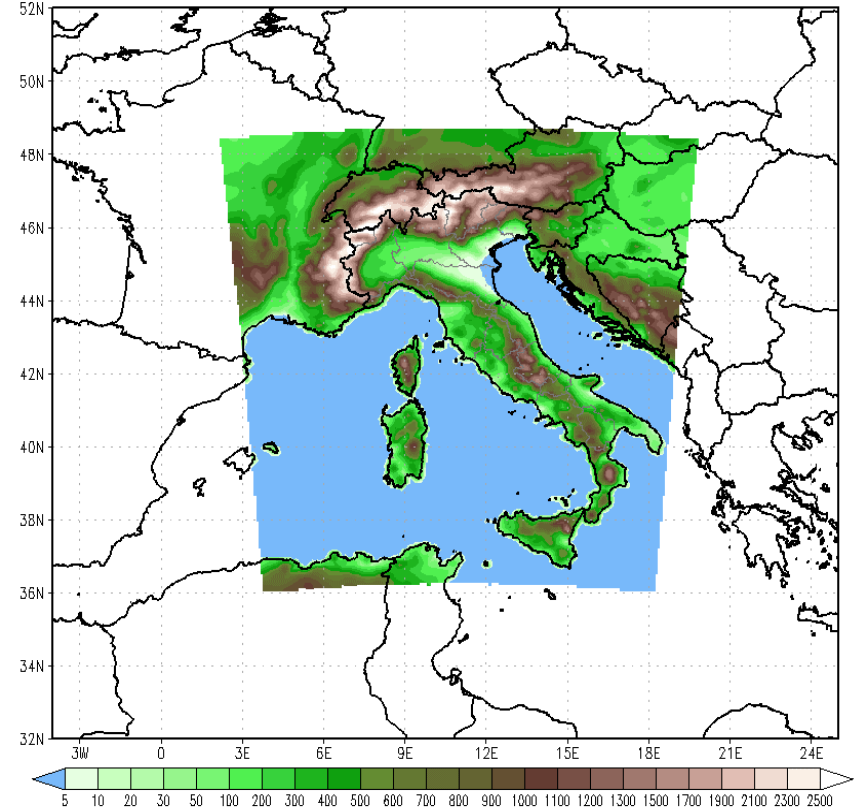
Fig. 2. WRF domain and orography description Figure 2. WRF domain and orography description.